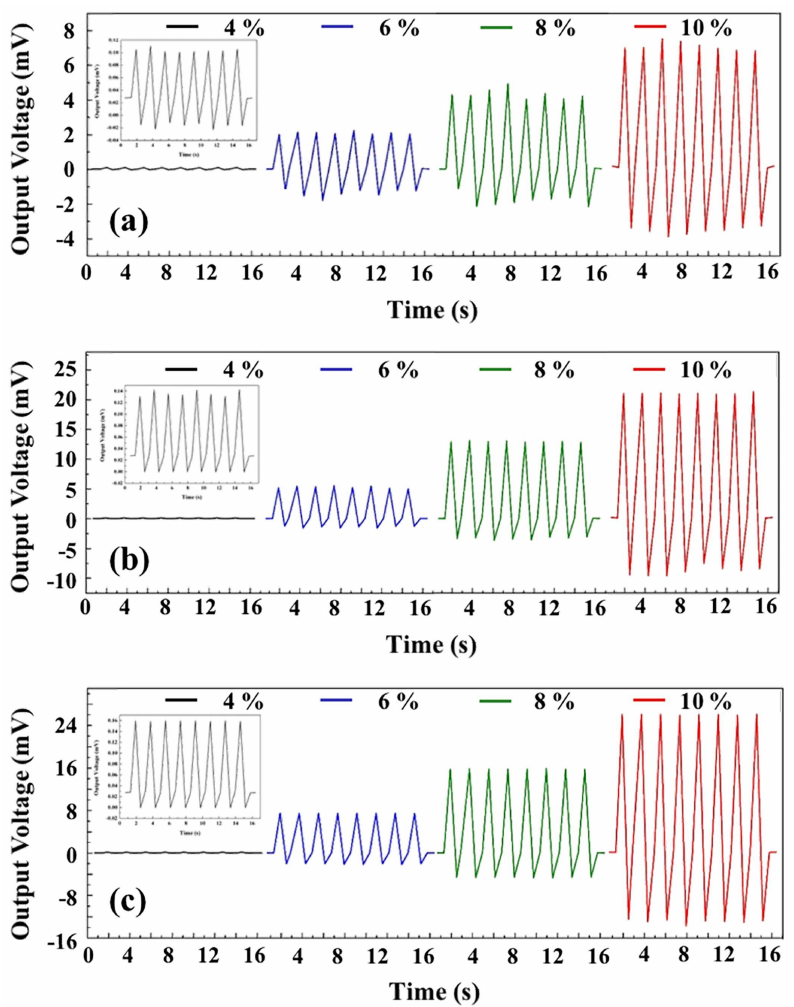
Figure 6. Piezoelectric output voltage waves of the piezoelectric units with: ( a ) randomly oriented electrospun PVDF; ( b ) aligned electrospun PVDF; and ( c ) aligned electrospun PVDF/CNT under tensile strains from 4% to